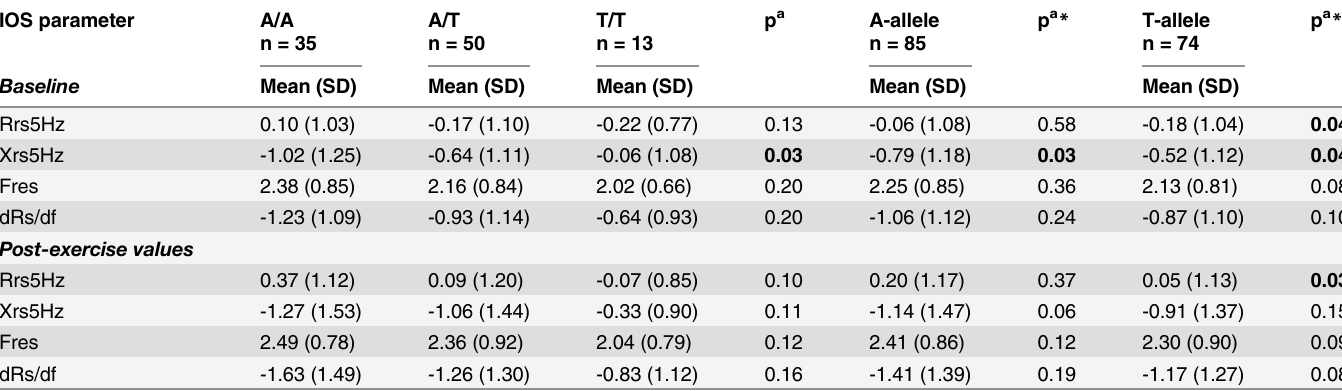
Table 4. Impulse oscillometry presented as Z-scores in relation to IL-10 rs1800890 polymorphism in 98 children under the age of seven after hospi- talisation for bronchiolitis at less than six months of age. IOS parameter